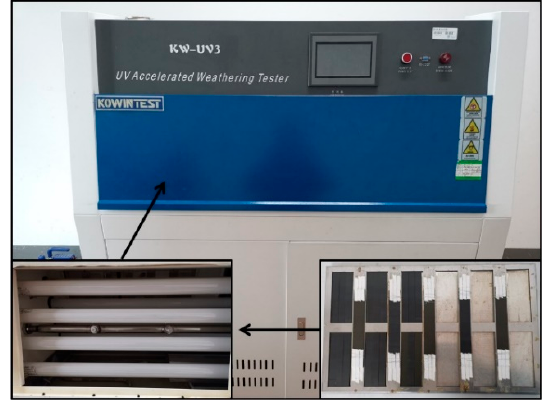
Figure 4. UV exposure chamber.